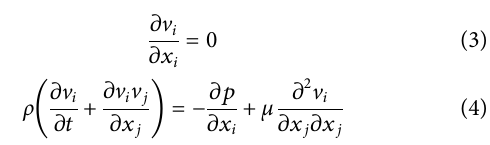
Frontiers in Bioengineering and Biotechnology |